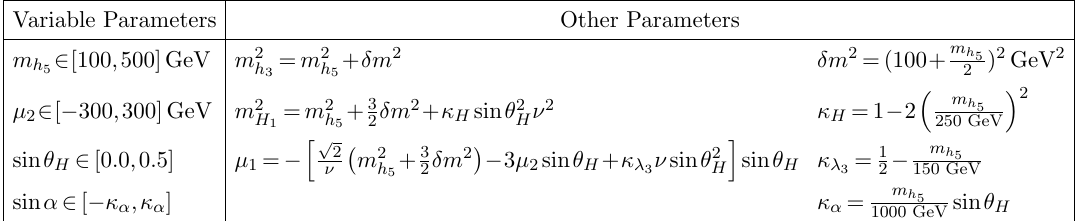
Table 1 . The parameter choice in low mass benchmark.